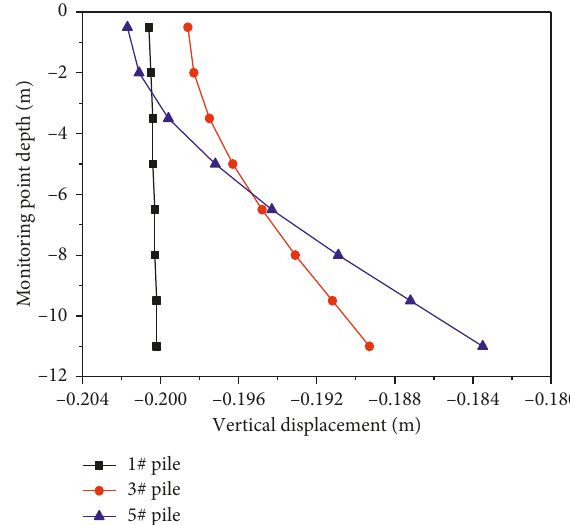
Figure 14: Vertical displacement of the pile.